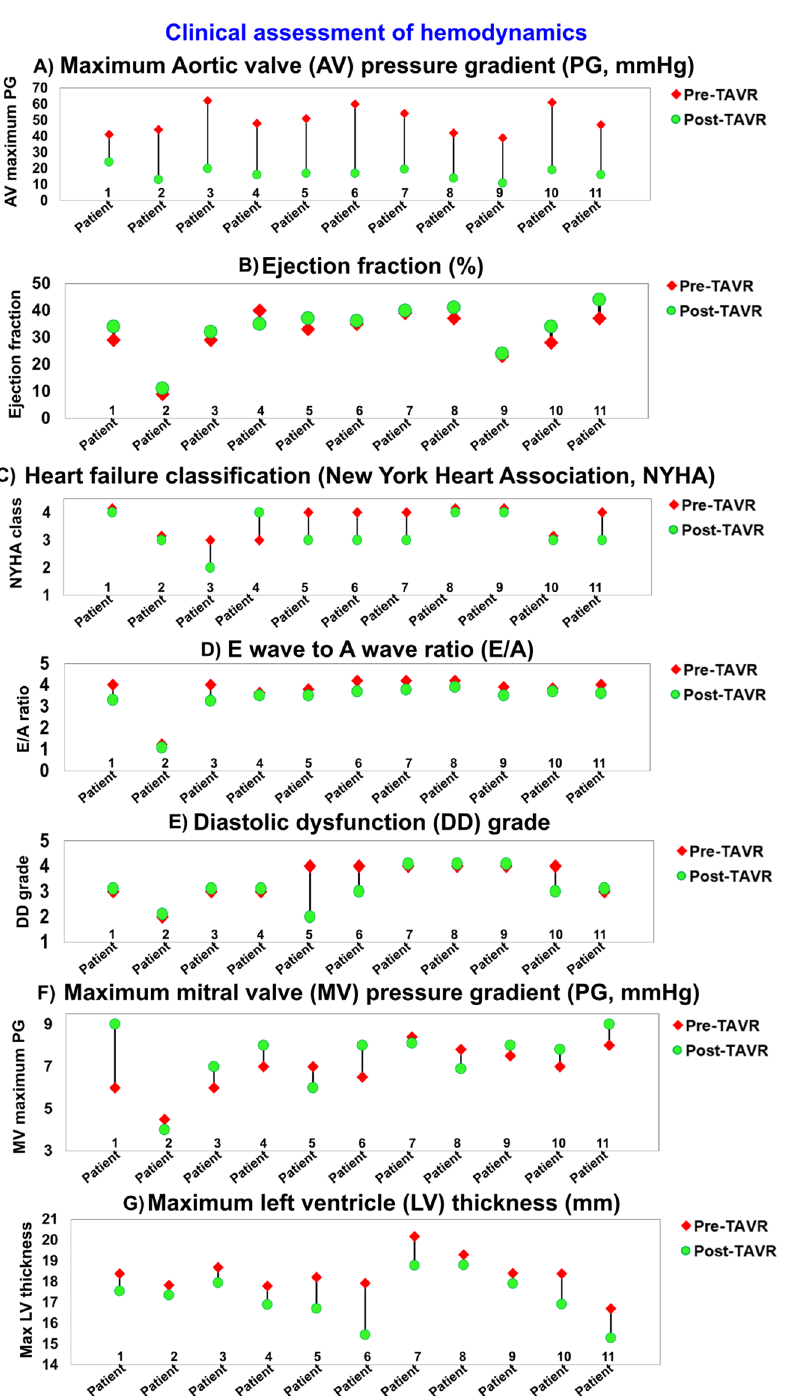
Figure 5. Changes in clinical assessment of hemodynamics in patients between baseline and 90-day post-TAVR (N = 11). ( a ) Maximum aortic valve pressure gradient; ( b ) Ejection fraction; ( c ) Heart failure classification; ( d ) E wave to A wave ratio (E/A); ( e ) Diastolic dysfunction grade; ( f ) Maximum mitral valve pressure gradient; ( g ) Maximum left ventricle